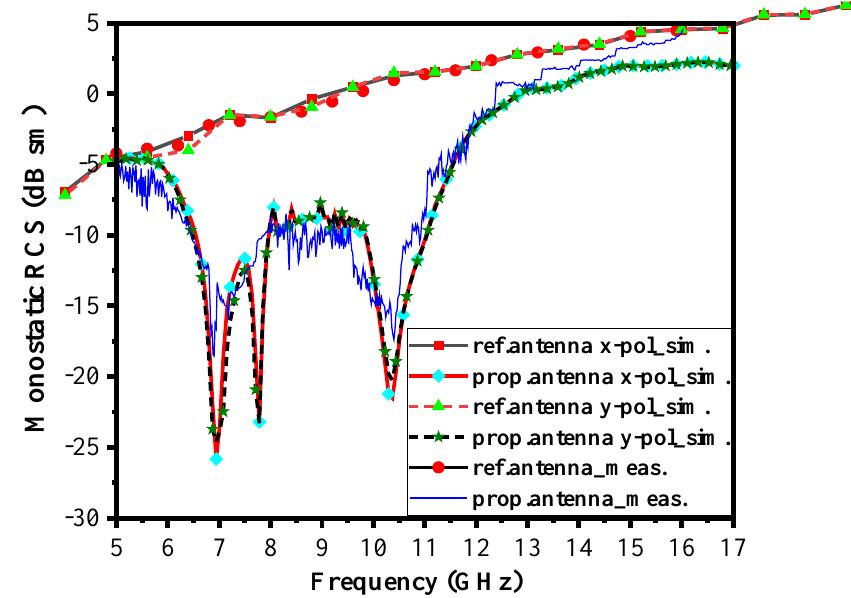
Figure 9. Simulations and measurements of the monostatic backscattering of the reference and proposed antenna.